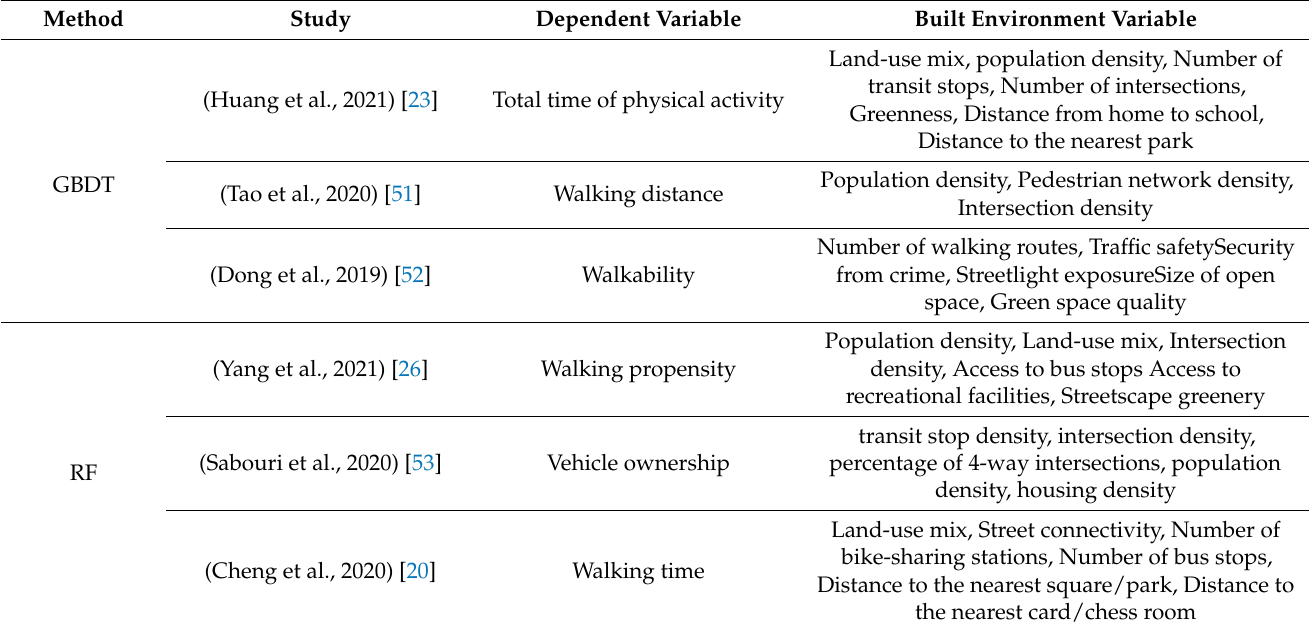
Table 1. Selected studies on the relationships between the built environment and travel behavior employing machine learning